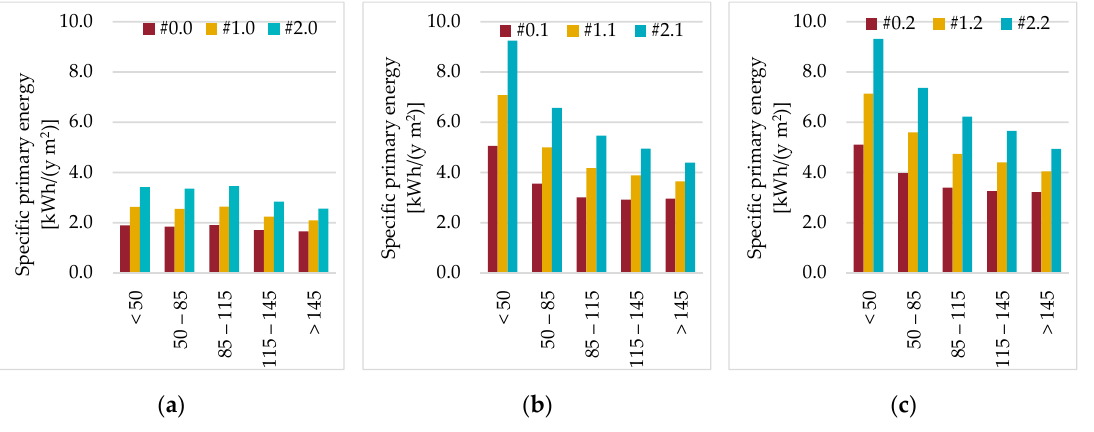
Figure 14. Milan: Specific primary energy consumption for cooling. ( a ) Existing equipment; ( b ) existing equipment + 1 air conditioner; ( c ) existing equipment + 2 air conditioners.